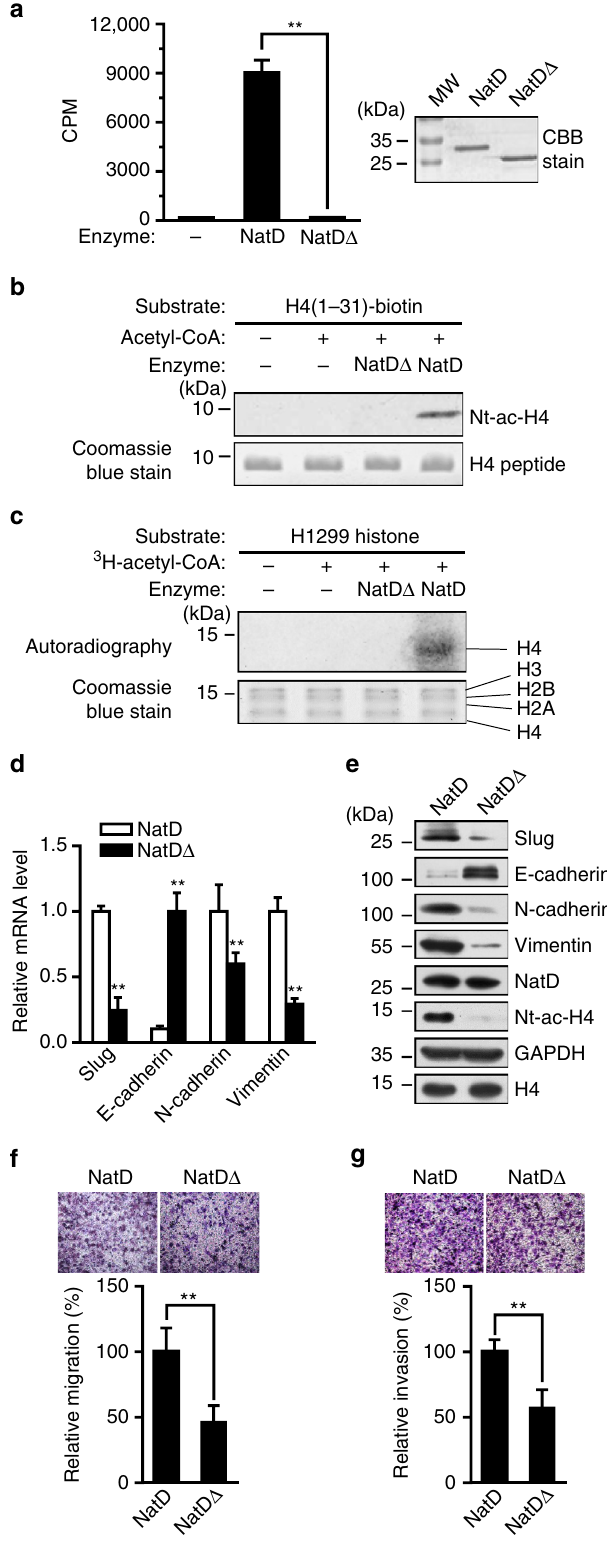
| DOI: 10.1038/s41467-017-00988-5 |